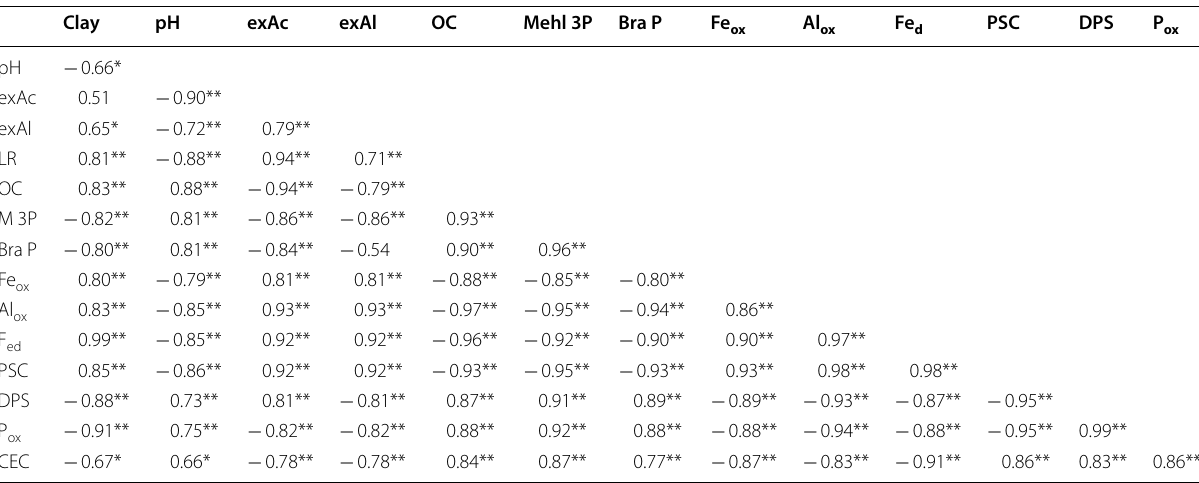
Table 8 Correlation table for some soil properties